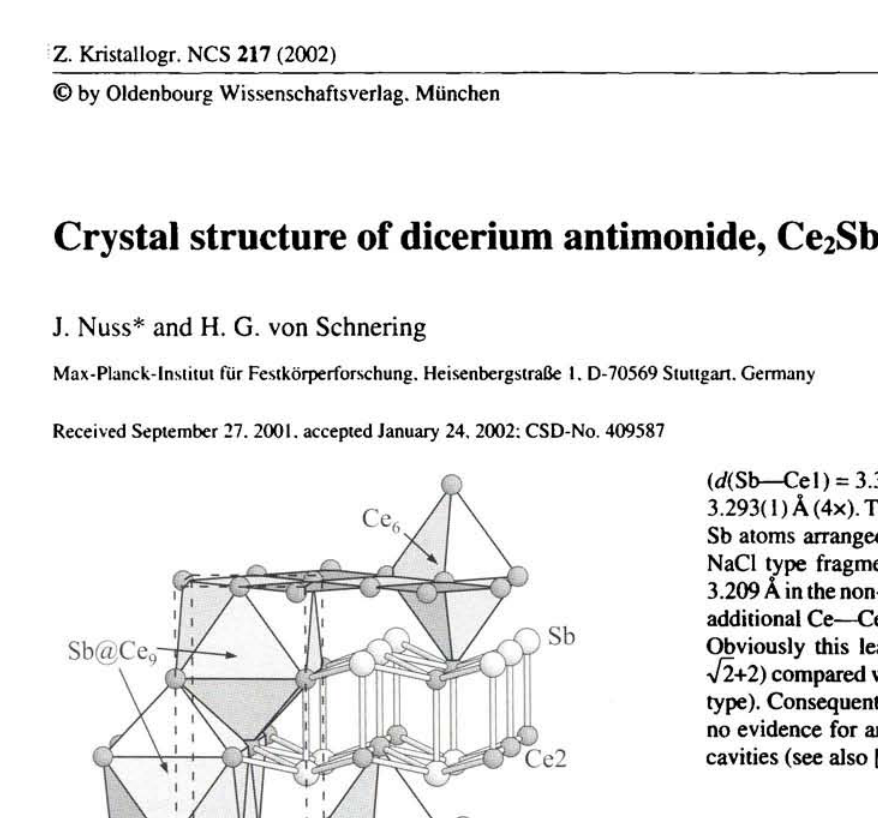
Table 1. Data collection and